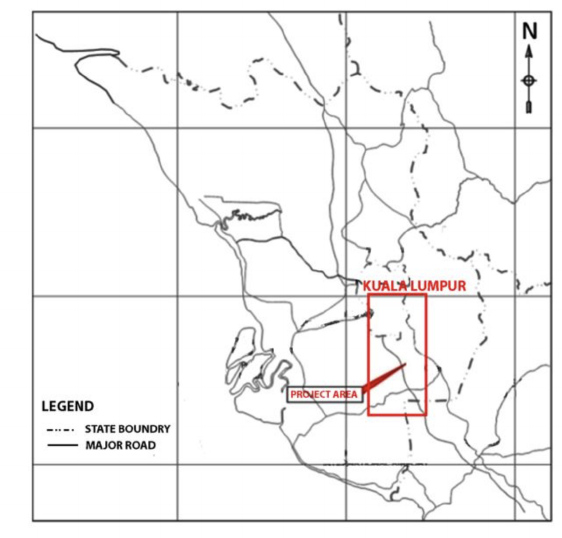
Fig. 1. Location of the KVMRT project